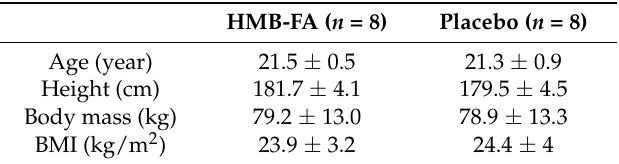
Table 1. Subject characteristics (mean ±